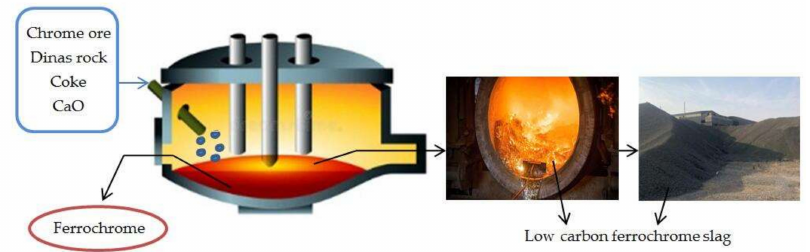
Figure 1. The production process of low carbon ferrochrome